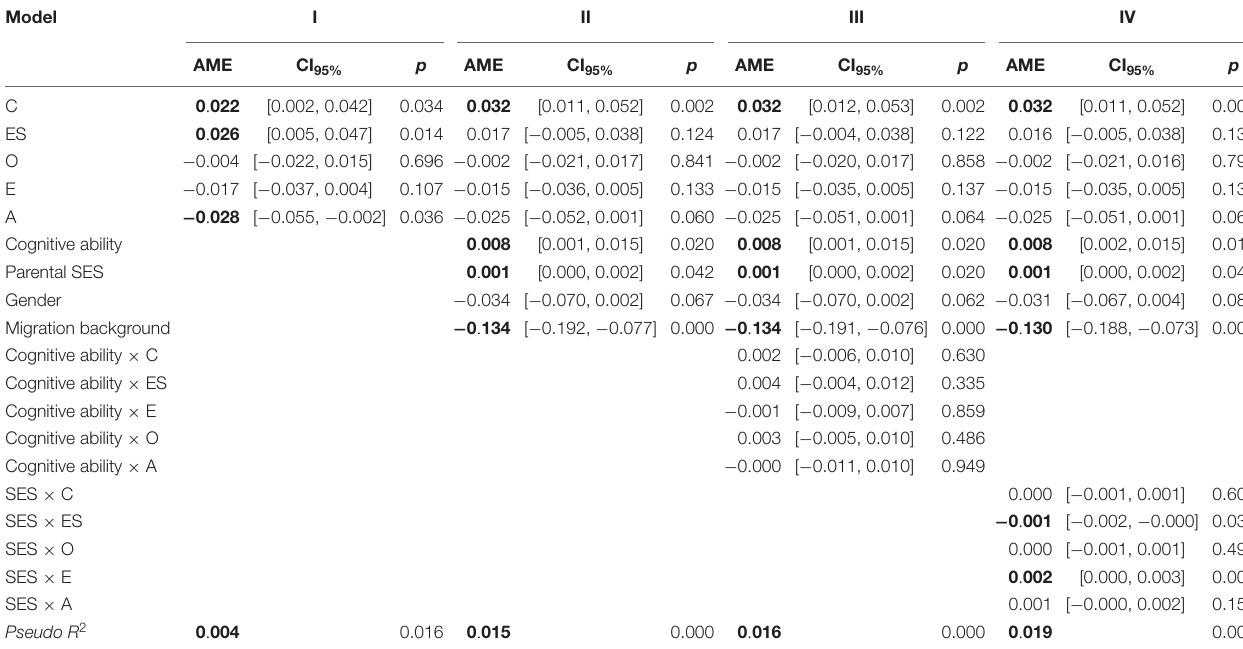
TABLE 5 | Average marginal effects for starting a VET position within 1 year after graduation (given the receipt of an acceptance for a VET position) regressed on the Big Five and the covariates.